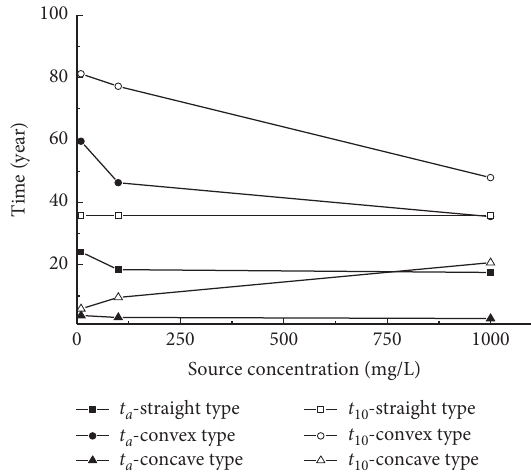
Figure 4: Relationship between t a , t 0.1 and source concentration in Cases 1 ∼